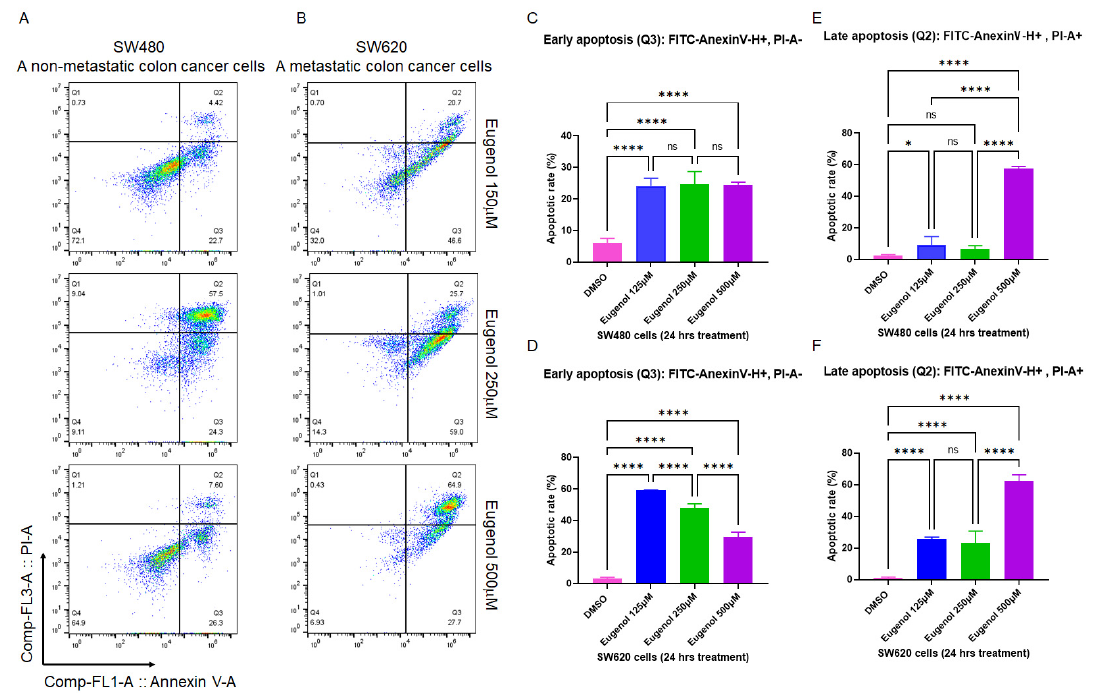
Figure 3. EUG induces apoptosis in metastatic colon cancer cells. Panels ( A – F ): The two isogenic human colon cancer SW480 and SW620 cell lines belong to separated tumor masses removed from the same patient. SW480 cells are initiated from the primary tumor, whereas the SW620 cells form the metastatic lymph node lesion. SW480 (Primary CRC) cells and SW620 (metastatic CRC) cells were incubated with DMSO or EUG (125, 250, and 500 µM) for 24 h, followed by PI/annexin V flow cytometry analysis. Collected flow cytometry results were analyzed using FlowJo software to determine the % of Annexin V-positive (early apoptosis) versus Annexin V/PI-positive cell populations in the presence and the absence of EUG. Panels ( A , C , E ) show significant induction of late apoptosis in SW480 by 500 µM EUG. Similar significant late apoptosis signals were measured in metastatic SW620 cells in the presence of 500 µM EUG (Panel ( F )). Meanwhile, measurement of early apoptosis (Annexin-positive, PI-negative) showed a sensitivity of both cell lines to EUG (Panels ( C , D )). Four independent experiments were carried out in triplicate ( p -value * < 0.05, **** < 0.0001, mean ± standard deviation). ns—non significant.